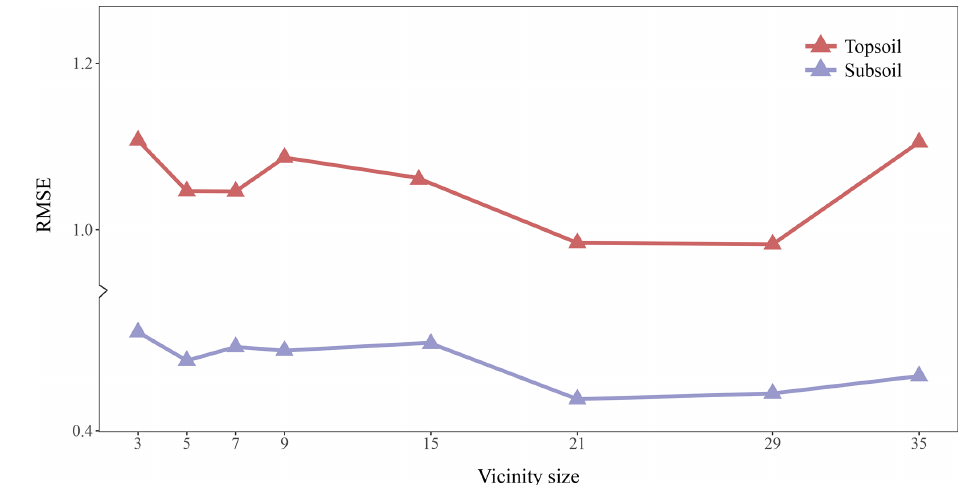
Figure 4. Effect of the vicinity size of input images. The RMSE (in g100g − 1 ) corresponds to the error between the predictions and measured values in the test set.